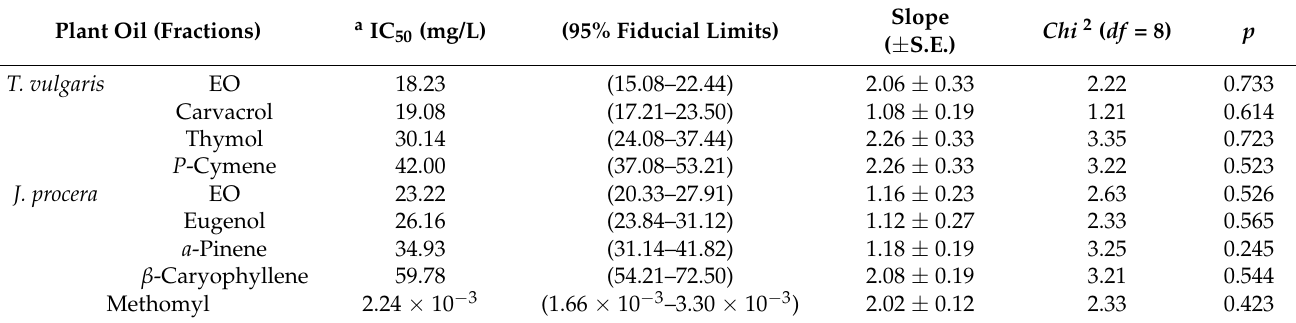
Table 6. Acetylcholinesterase (AChE) inhibition in T. granarium larvae by the tested oils and their terpenes.